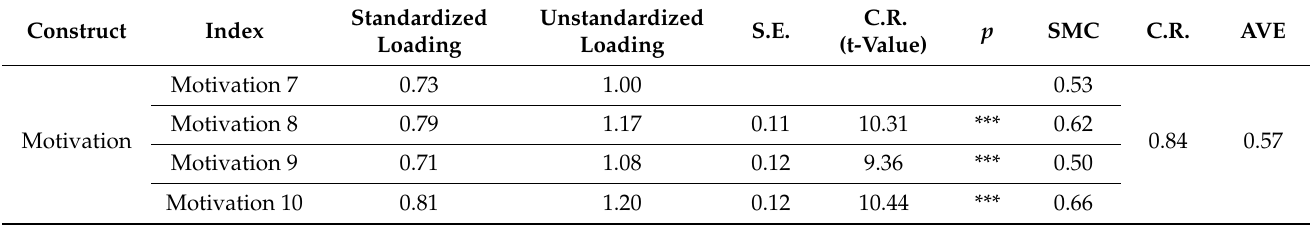
Table 4. Motivation–verification